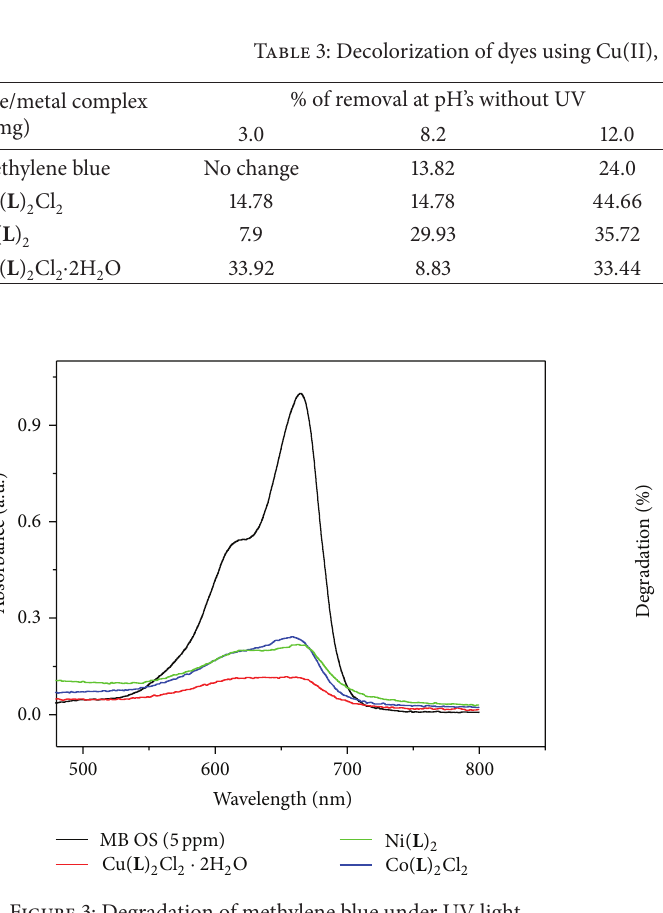
Figure 3: Degradation of methylene blue under UV light.